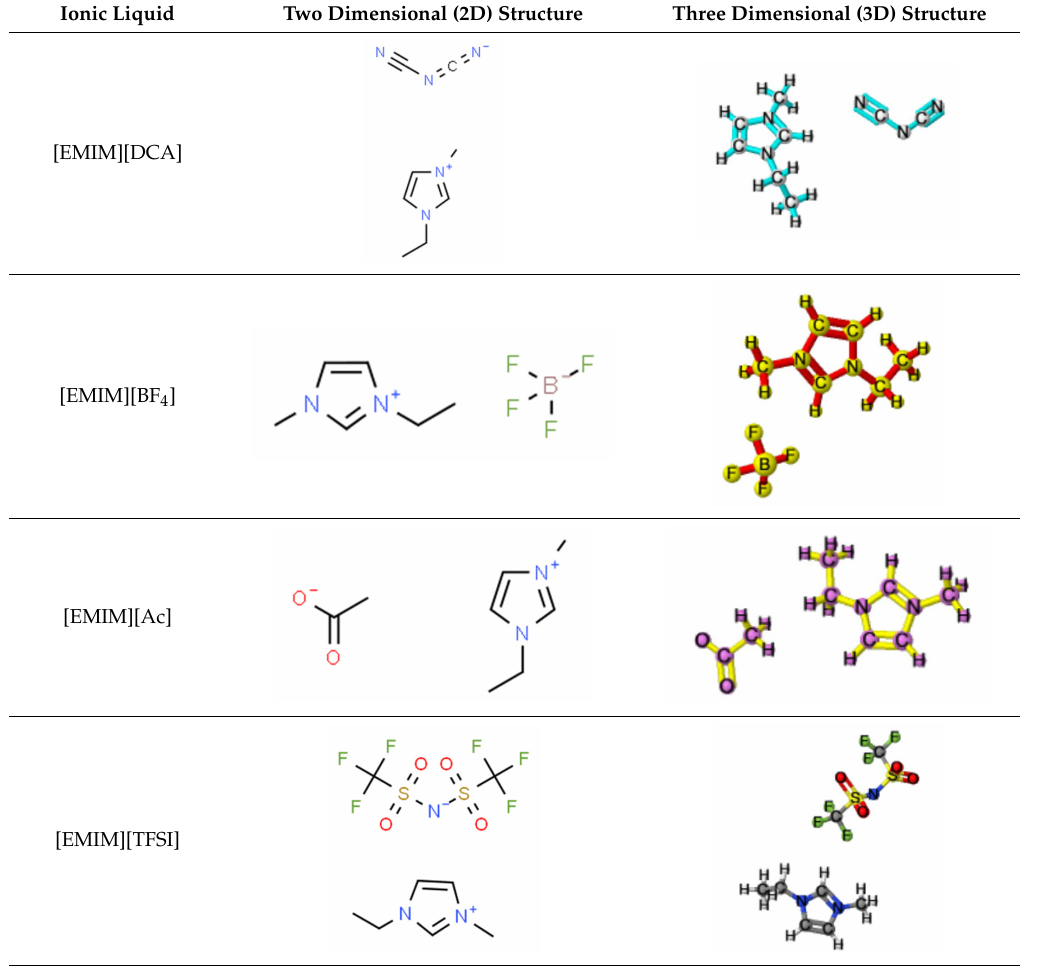
Table 4. Two and three dimensional structures of the most used ionic liquids mentioned in this study. Ionic Liquid Two Dimensional (2D) Structure Three Dimensional (3D)